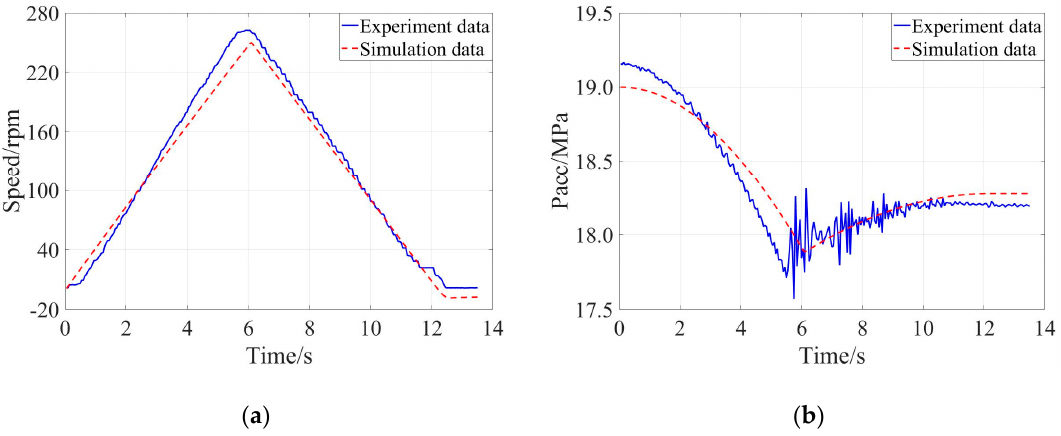
Figure 17. Comparison of the experimental result and simulation result when the initial braking speed was 200 rpm: ( a ) Evolution of speed of flywheel, ( b ) Evolution of pressure of accumulator.